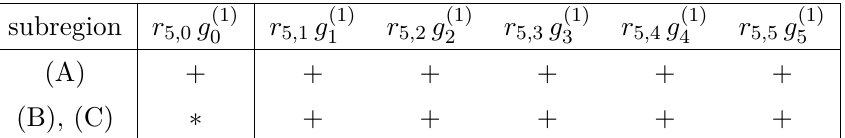
Table 4 . Signs of the six terms in the one-loop ( L = 1 ) expression (3.21) of f (1) kinematic